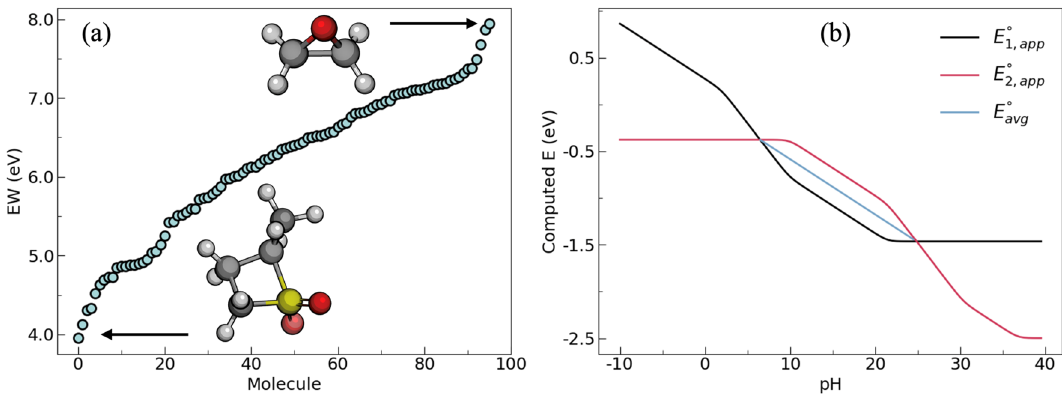
Figure 8. Sample calculations of ( a ) electrochemical stability window of additives and cosolvents relevant to Li-ion battery and ( b ) equilibrium potential diagram resulting from a two-step PCET reaction of a quinone molecule using the redox potential